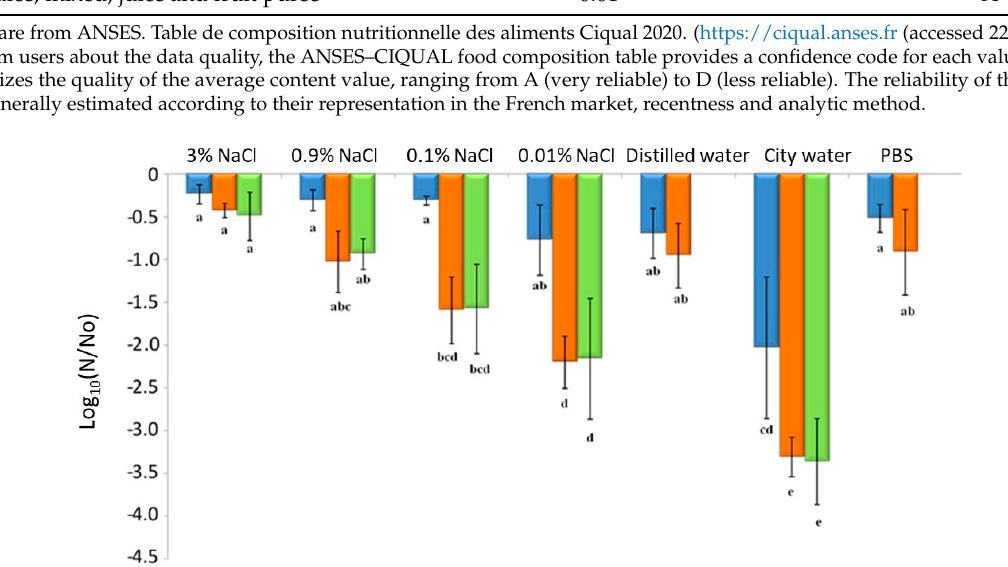
Figure 6. The decreased cultivability of L. monocytogenes strain EGDe dehydrated at 25 ◦ C and 75% RH for 3 h and rehydrated in various liquid matrices. The bacteria were suspended and then dried in different solutions: 3% NaCl (0.989 a w ), 0.9% NaCl (0.997 a w ), 0.1% NaCl (0.999 a w ), 0.01% NaCl (0.999 a w ), distilled water (1.000 a w ), city water (1.000 a w ) and PBS (1.000 a w ). Subsequently, rapid rehydration was performed in ( (cid:4) ) PBS, ( (cid:4) ) distilled water or ( (cid:4) ) the same liquid matrix used for dehydration. Error bars correspond to the standard deviation calculated from four independently repeated experiments. Histogram bars followed by different letters indicate significant differences ( p < 0.05) determined by Tukey post hoc tests.